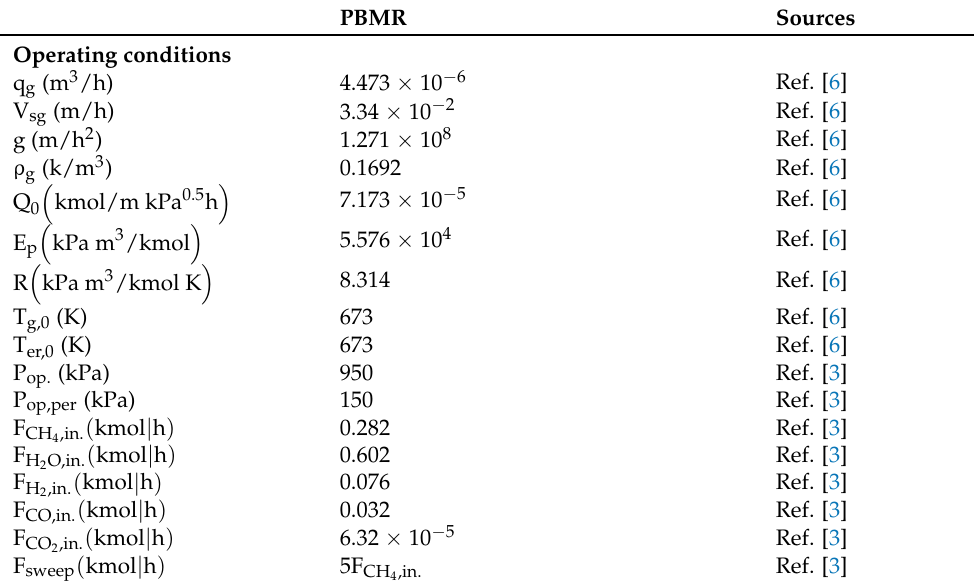
Table 2. Operating conditions at the inlet from